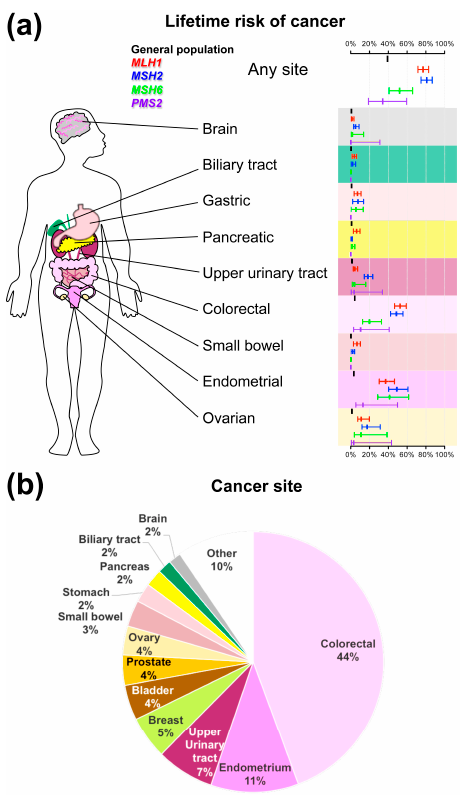
Figure 3. ( a ) The lifetime risk of cancer in patients with Lynch syndrome based on pathogenic MMR gene and site. The risks of endometrial and ovarian cancer were calculated in a female population. ( b ) Frequency of cancer by site in 6350 carriers of pathogenic MMR variants from the Prospective Lynch Syndrome Database (skin cancer were excluded) [5].